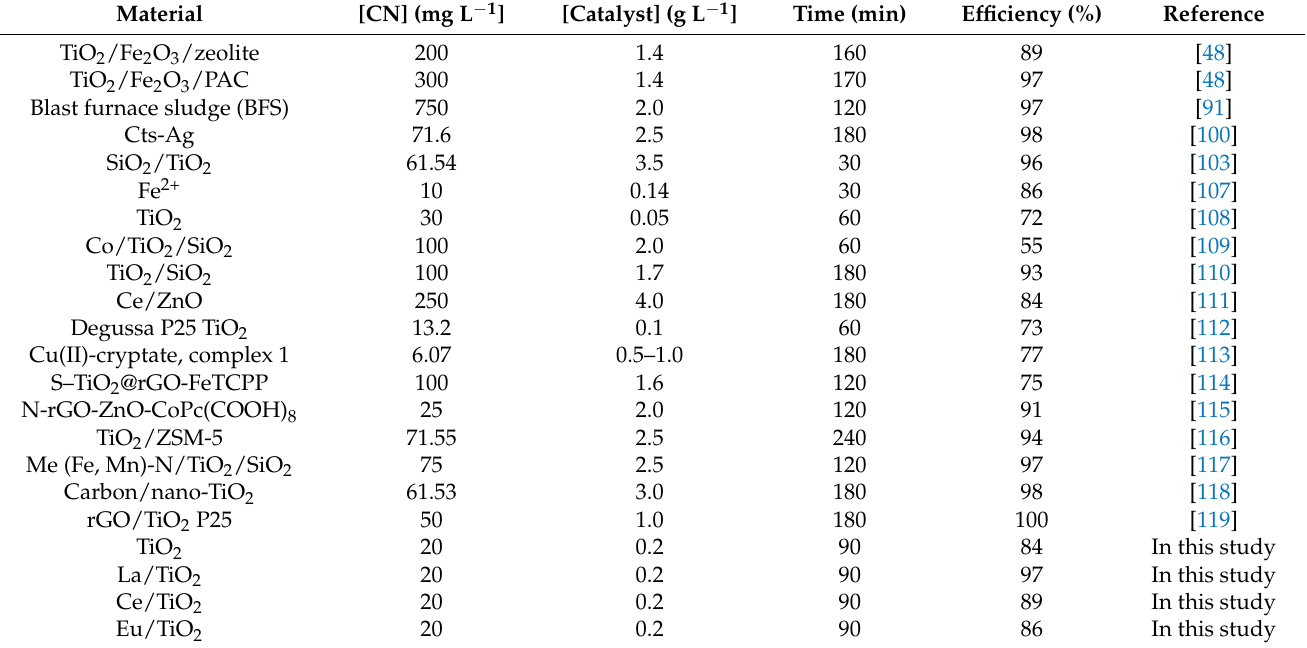
Table 6. Comparison of photodegradation efficiency (%) of various materials for cyanide